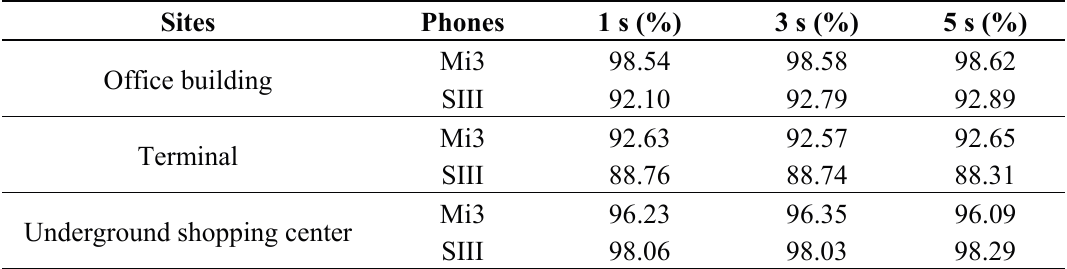
Table 7. Floor-positioning results under different carrying modes and time